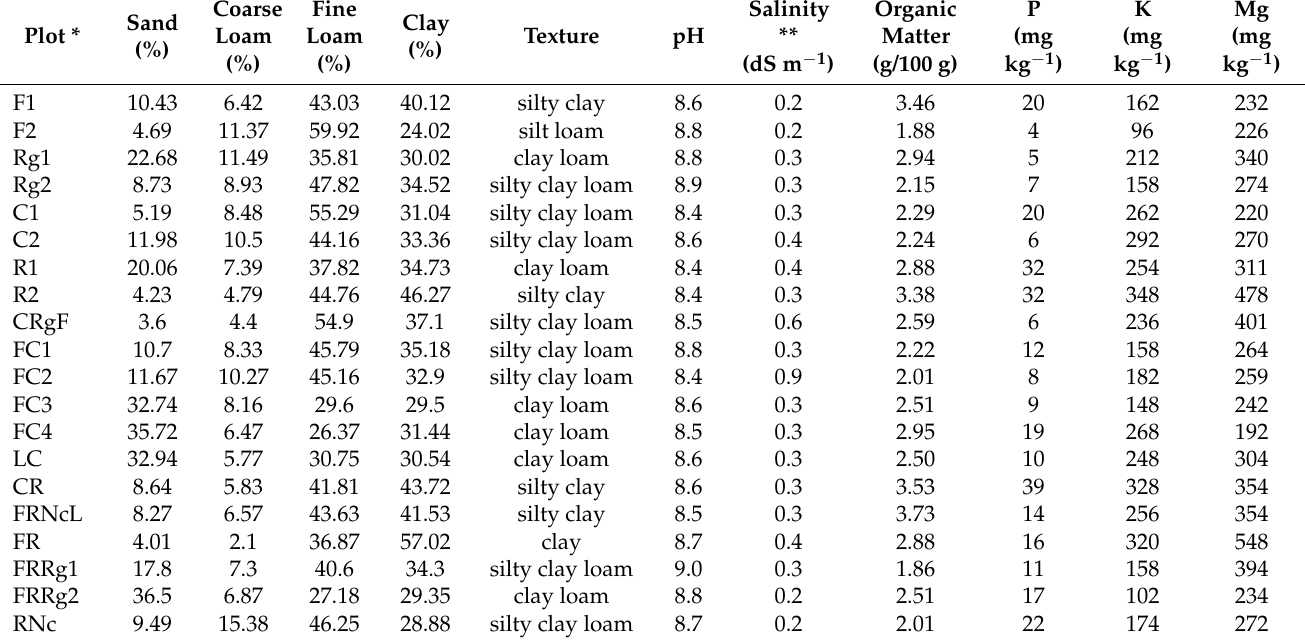
Table 3. Soil analysis data of the 20 surveyed fields in Aragon, Spain. In bold, samples that were subjected to an additional salinity test due to salinity ≥ 0.4 dS m − 1 .